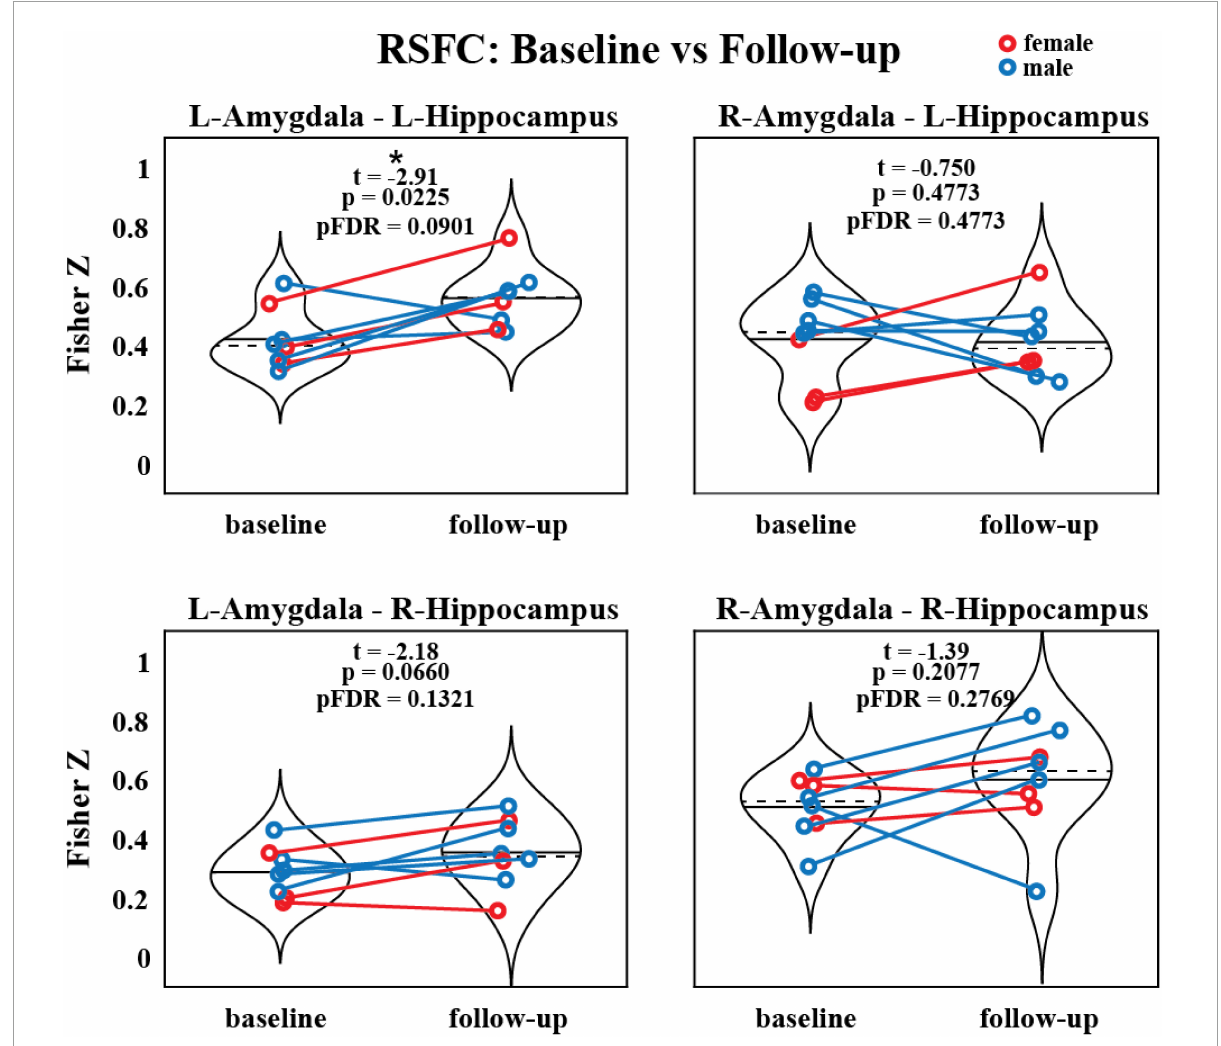
FIGURE3 Resting-state functional connectivity between the amygdala and hippocampus before and after MDMA-AT. P -values from a two-sided, paired t-test. Blue = male. Red = female. Black solid and dashed lines indicate group means and medians, respectively ( N = 8; t-statistics indicate baseline > follow-up; *uncorrected p <